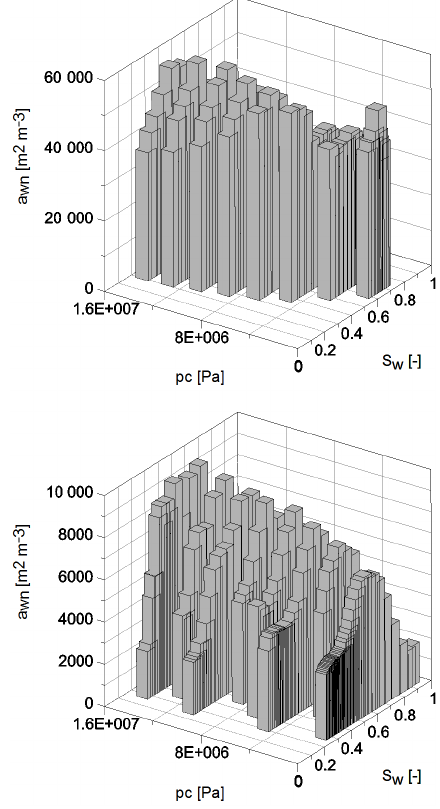
Figure 12. 3-D bar plots of the p c – S w – a wn relationship obtained from the µ -CT-based pore geometry (above) and the µ -CT-based pore network geometry (below). Note the different scaling in a wn